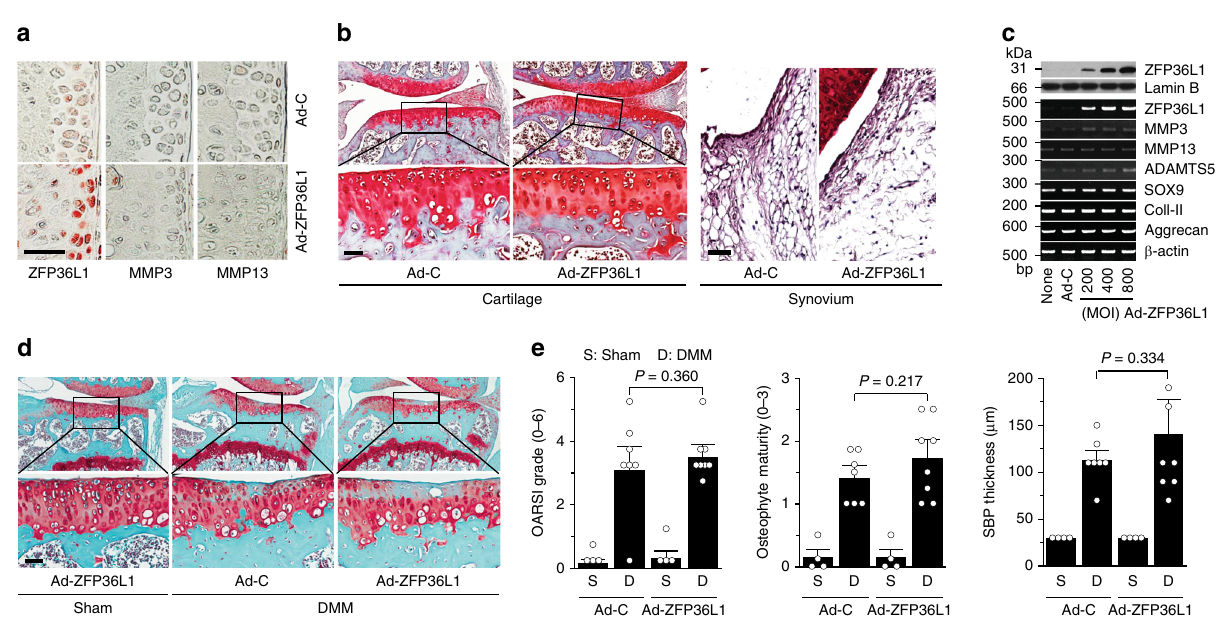
Fig. 2 Overexpression of ZFP36L1 in joint tissues does not modulate OA pathogenesis. a , b WT mice were IA injected with Ad-C ( n = 6 mice) as a control or Ad-ZFP36L1 ( n = 8 mice). Representative immunostaining images of ZFP36L1, MMP3, and MMP13 in cartilage sections ( a ). Cartilage destruction and synovitis were determined by Safranin-O staining and H&E staining 3 weeks after IA injection ( b ). c Protein and mRNA levels of the indicated molecules in chondrocytes infected with Ad-C (800 MOI) or the indicated MOIs of Ad-ZFP36L1 for 36 h. Representative images are presented from six independent primary cultures of chondrocytes. d , e Sham-operated ( n = 4 mice) or DMM-operated ( n = 7 mice) WT mice were IA injected with Ad-C as a control or Ad-ZFP36L1 to overexpress ZFP36L1 in joint tissues. Representative Safranin-O staining images of joint sections ( d ) and scoring of OARSI grade, osteophyte maturity, and subchondral bone plate thickness ( e ) at 8 weeks after operations. Means ± 95% CI with Mann – Whitney U test for OARSI grade and osteophyte maturity. Means ± s.e.m. with two-tailed t -test for SBP thickness. Scale bar: 50 μ m